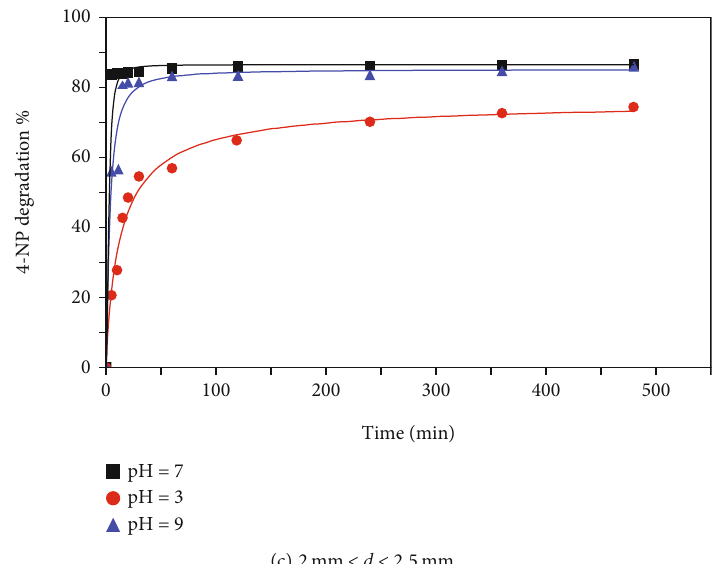
Figure 7: E ff ect of solution pH on the 4-nitrophenol degradation by catalytic oxidation using catalyst grains with di ff erent diameters. Experimental conditions: 0.2g of catalyst, 11 mg/L of 4-nitrophenol concentration, and 27 ° C.